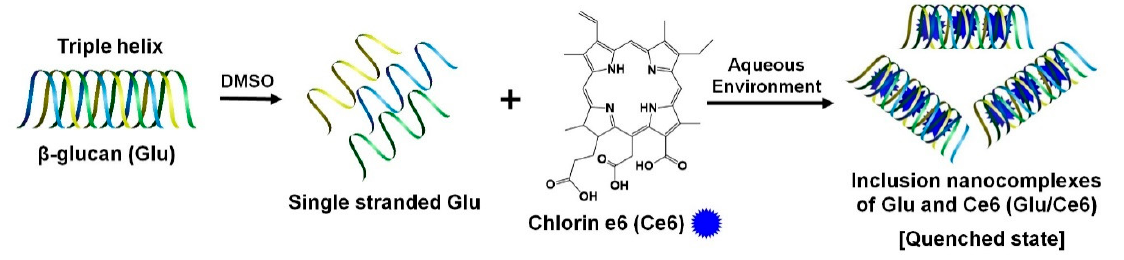
Figure 1. Schematic illustration of the preparation procedures of the Glu/Ce6 nanocomplexes.